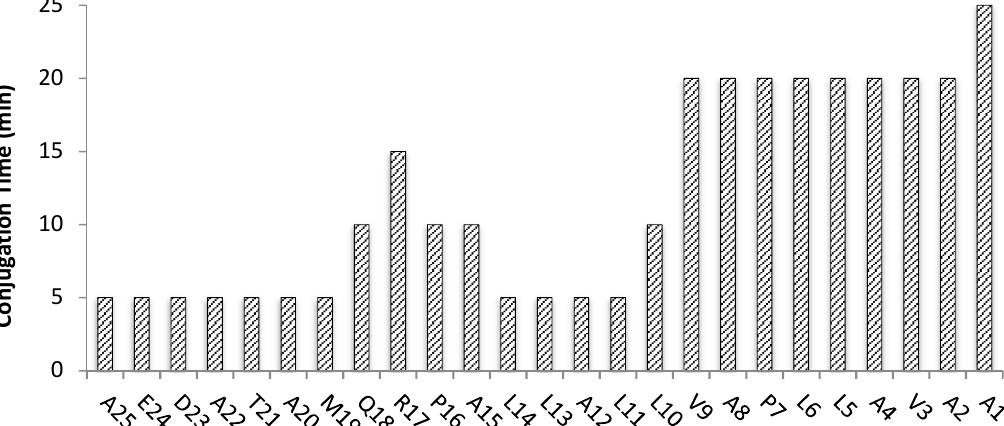
Figure 5. Conjugation times (min) for each amino acid of the 25-mer peptide Pep3 prepared by US-assisted SPPS. Total conjugation time was 295 min.